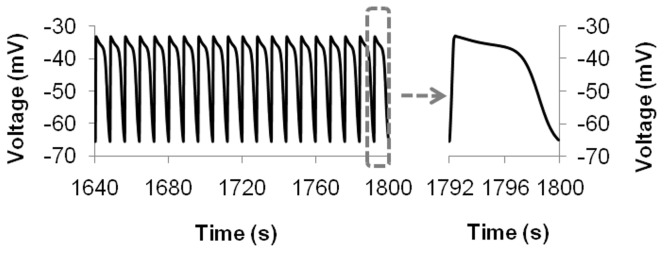
Simulated slow waves matched experimental control traces of
Figures 7A and 7B
 in [51].